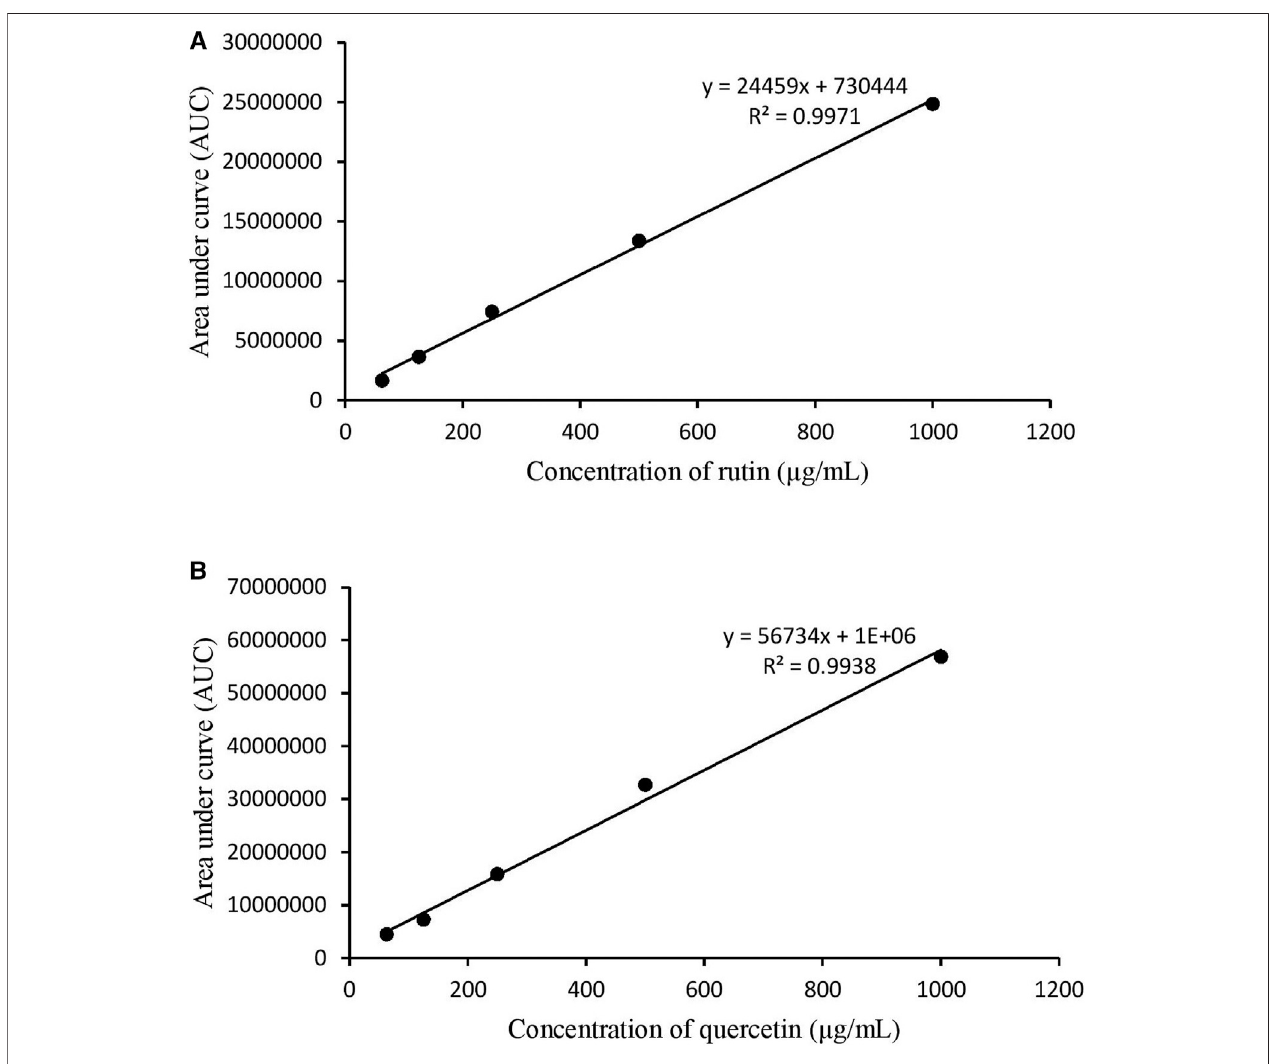
FIGURE 4 | Calibration curves for (A) rutin and (B) quercetin.